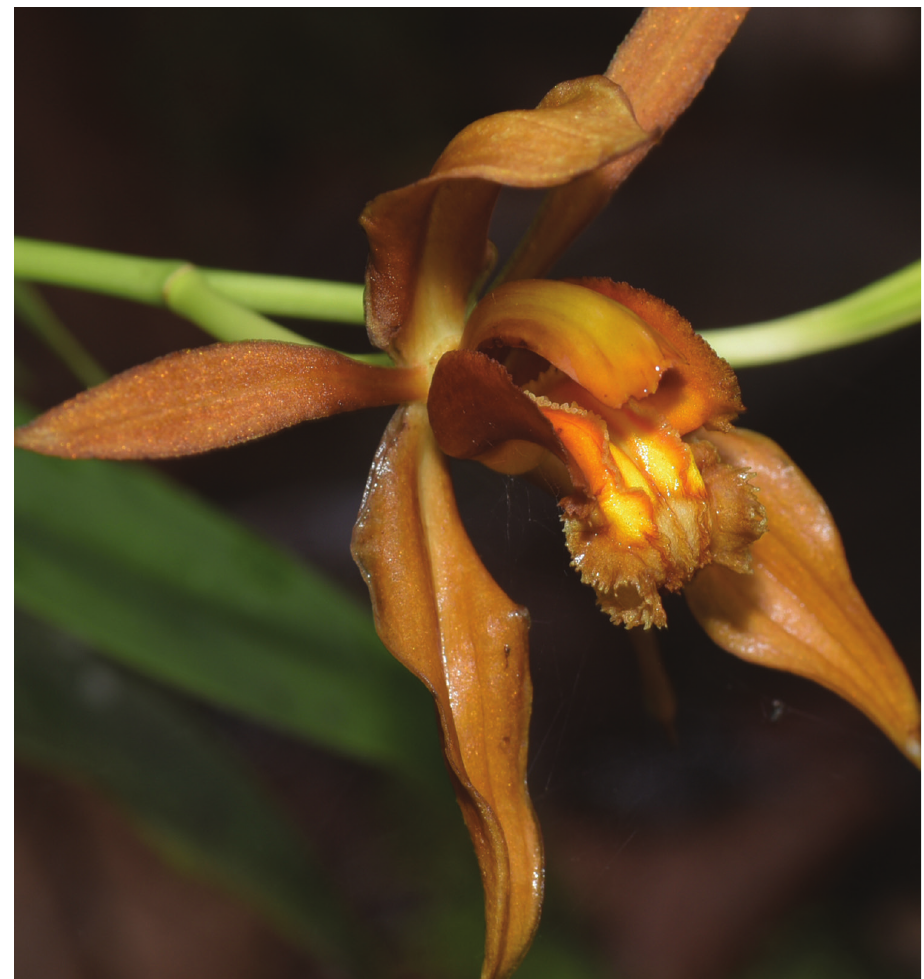
Figure 3. Close-up of flower of Coelogyne putaoensis , showing the white papillae on the two lateral lamellae. Photo by X.H.